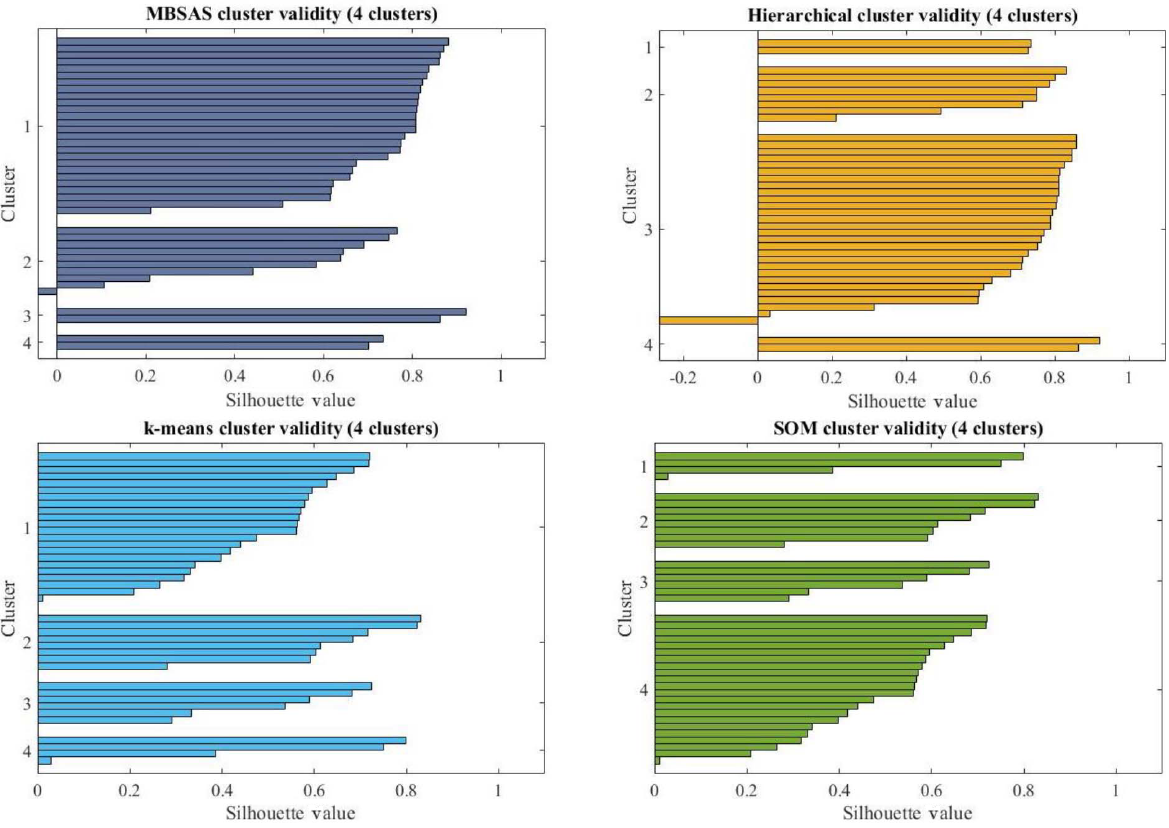
Figure 4. Silhouette plots for each method show the validity of each sample in a certain cluster. Positive values show that the sample has been clustered in the correct group and its magnitude is a measure of accuracy. Table 1. Mean, variance, minimum and maximum of 14 assayed rare earth elements in 42